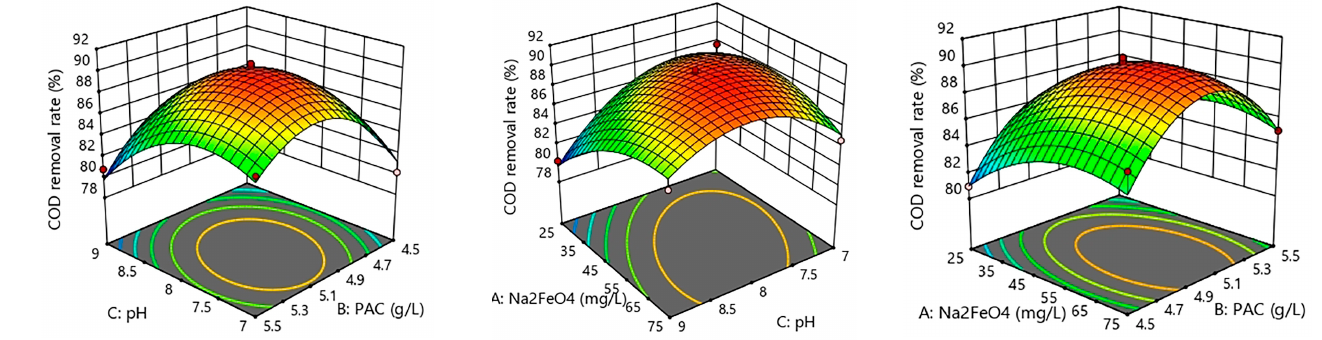
Figure 12. Interaction effect of Na 2 FeO 4 dosage, PAC dosage, and pH.